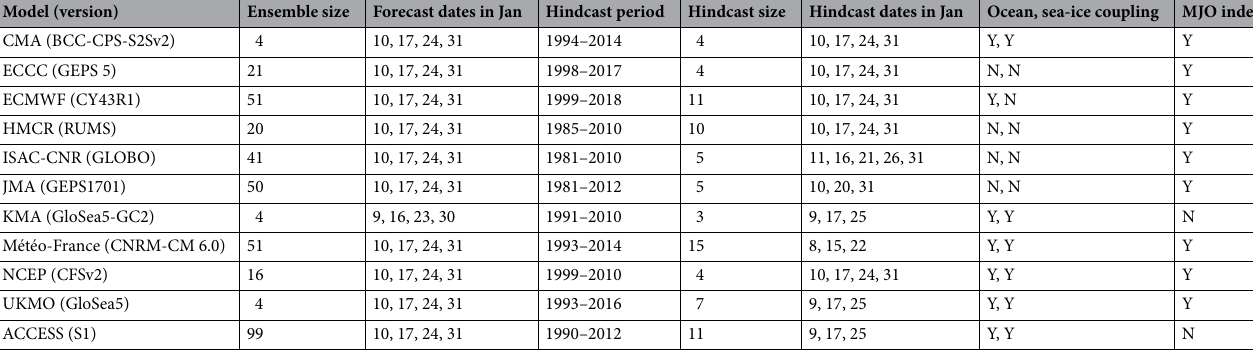
Table 1. Forecast and hindcast information from ten S2S models and ACCESS-S1. The S2S model resolution is 1.5° × 1.5° and ACCESS-S1 is 0.05° × 0.05°. All forecasts extend through to the end of the flood event (i.e., 6 February 2019), even for models with the shortest time range of 0–32 days (i.e., ECCC and ISAC-CNR) which finish on the 11 February for a 10 January